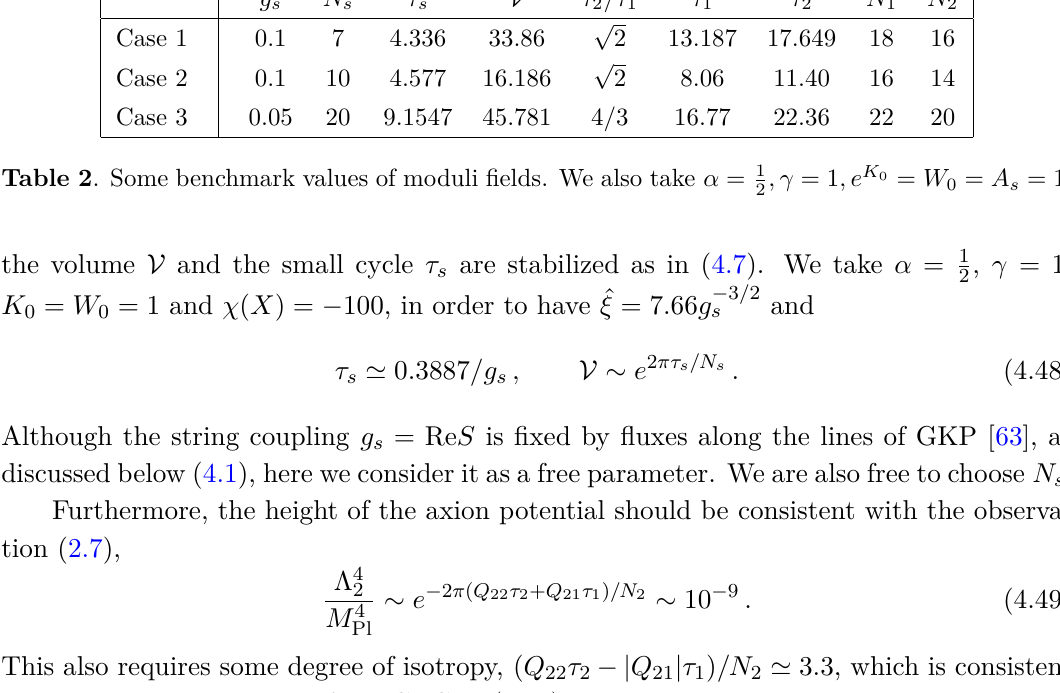
, γ = 1 , e K 0 = W 0 = A s = 1 . 2